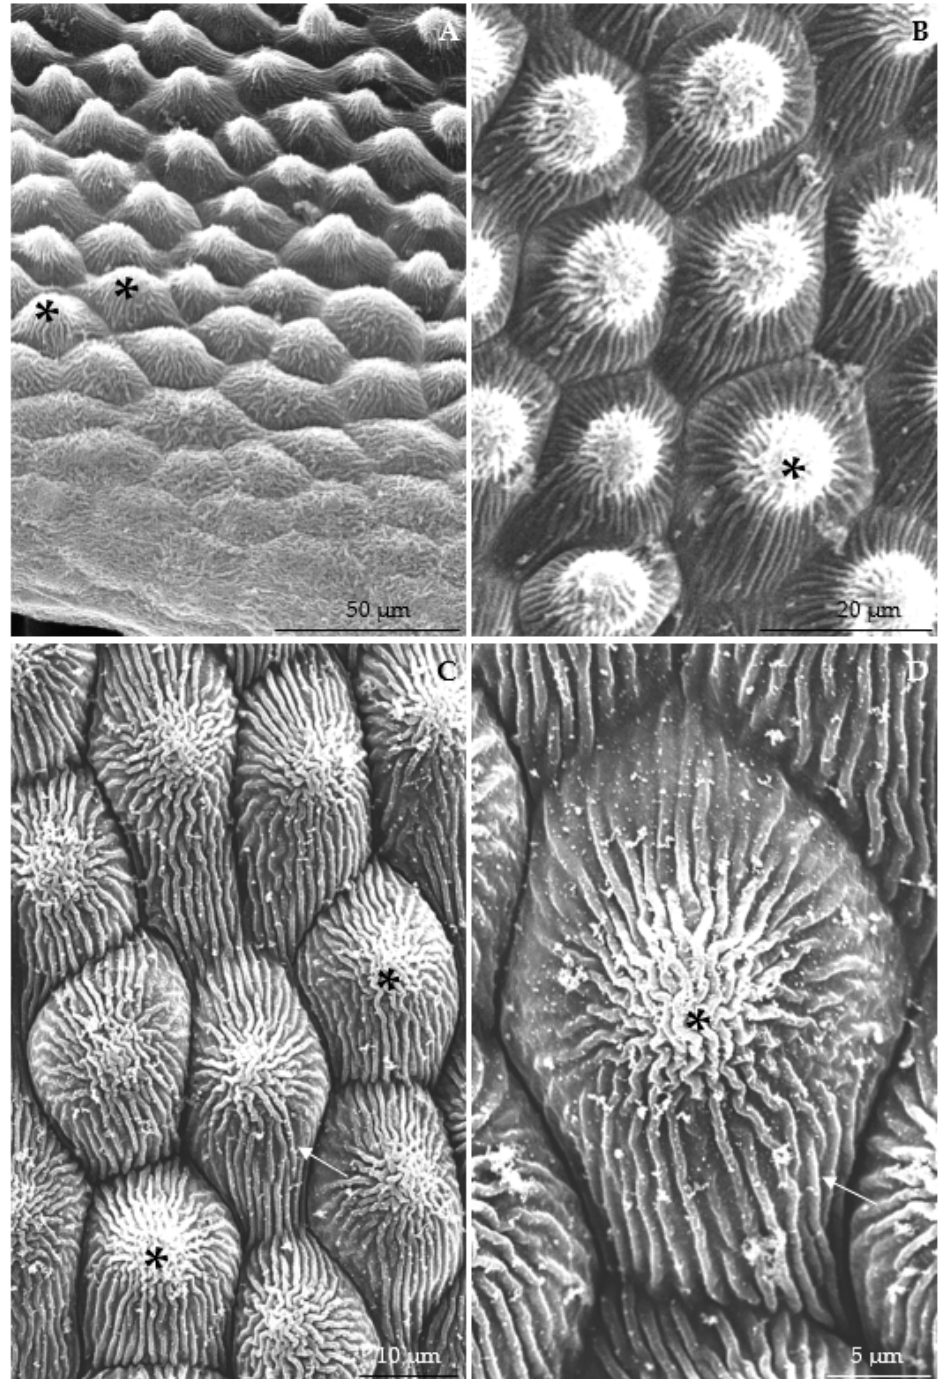
Figure 3. ( A – D ). Fragment of the adaxial surface of petal epidermis in R. idaeus ‘Glen Ample’ ( A ), ‘Laszka’ ( B ), ‘Polana’ ( C ), and ‘Polka’ ( D ) in the initial secretion phase. ( A , B ): cuticle striation; visible conical protuberances (asterisk) in the central part of the cells with lighter discoloration. ( C , D ): cuticular striae (arrow) densely distributed in the central part of the cells (asterisk) converging radially to adjacent cells and their looser arrangement near the cells.